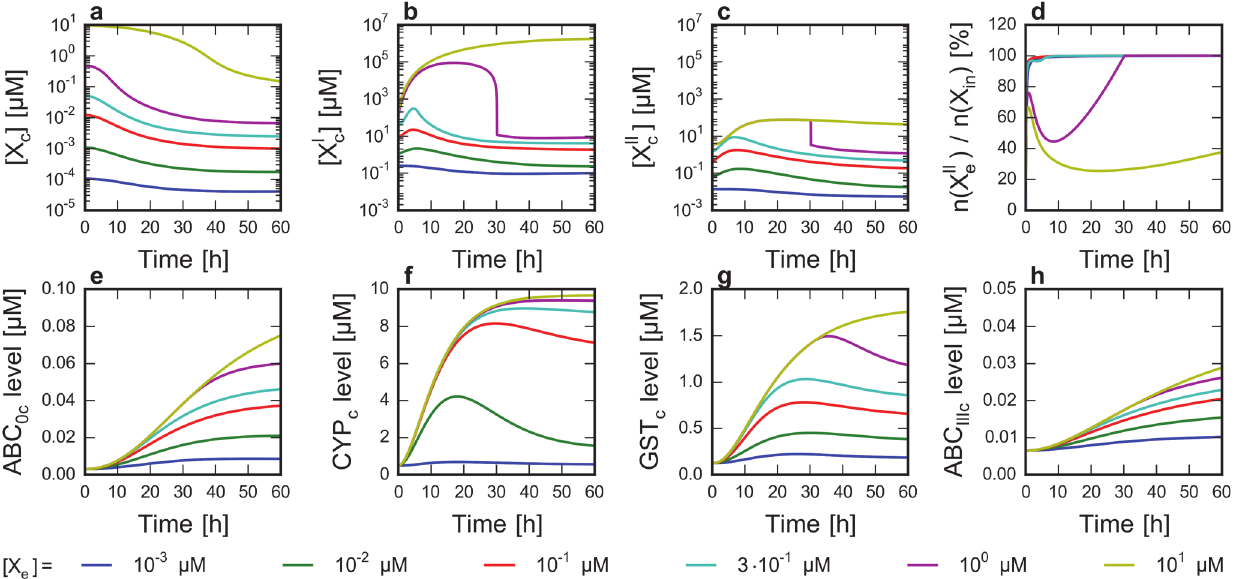
Fig 2. Effect of extracellular drug concentration on the level of network components. Six time course simulations were run from steady state as described in Methods. At t 0 = 0 h the addition of drug was simulated by setting the extracellular drug concentration ([X e ]) to a constant positive value between 1 nM and 10 μ M. a-c Concentration profile of the cytoplasmic form of the drug ([X c ]), its CYP-oxidized metabolite ([X ’ c ]) and GST-conjugated form ([X ” c ]). d n (X ” e )/n(X in ) ratio, where n(X ” e ) is the amount of the ABC III -excreted extracellular form of X ” and n(X in ) is the amount of drug intake. (Details of drug intake calculation are provided in S1 Text.) e-h Concentration profile of four key enzymes (ABC 0 , CYP, GST and ABC III ).